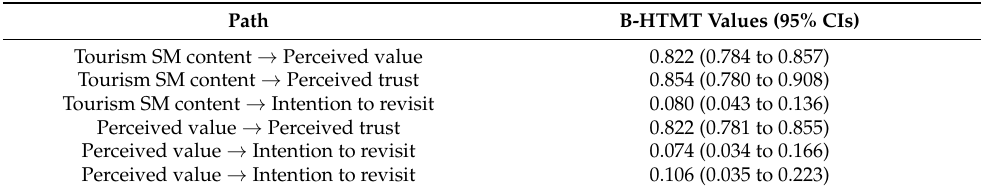
Table 4. Outcomes of the model heterotrait–monotrait